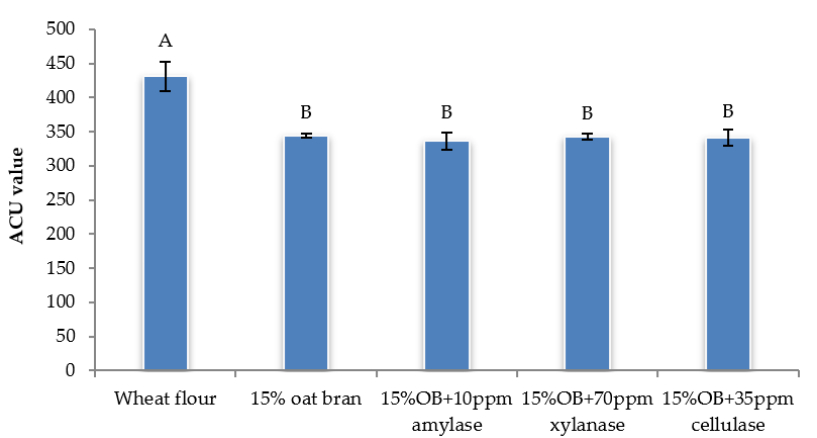
Figure 4. Fibre and starch content of Chinese steamed bread with single enzyme. Values with different letters differ significantly ( p < 0.05).